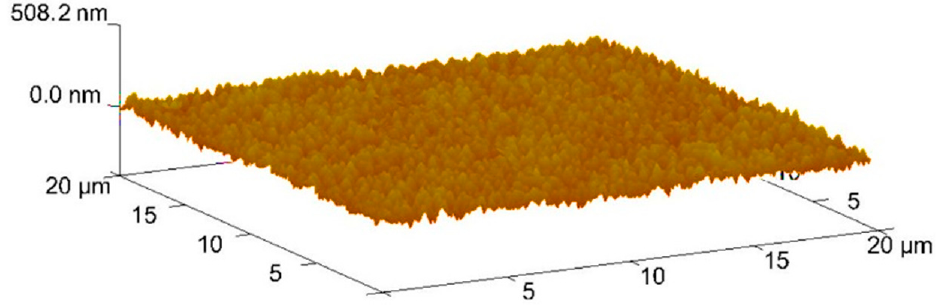
Figure 8. Load Topography of the coated surface analyzed by AFM.